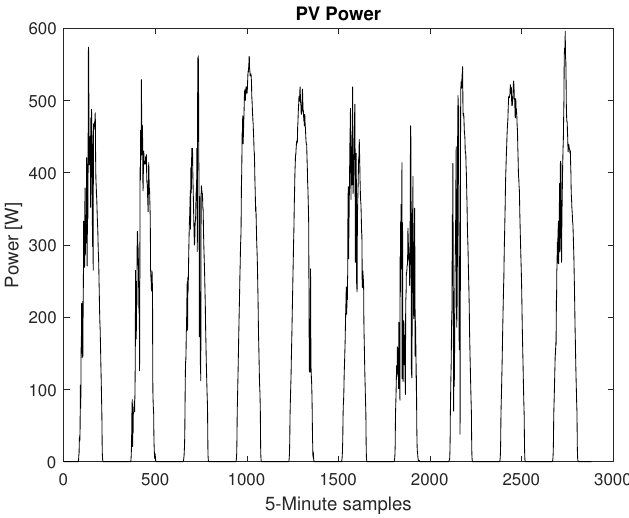
Figure 8. Ten days of PV-power